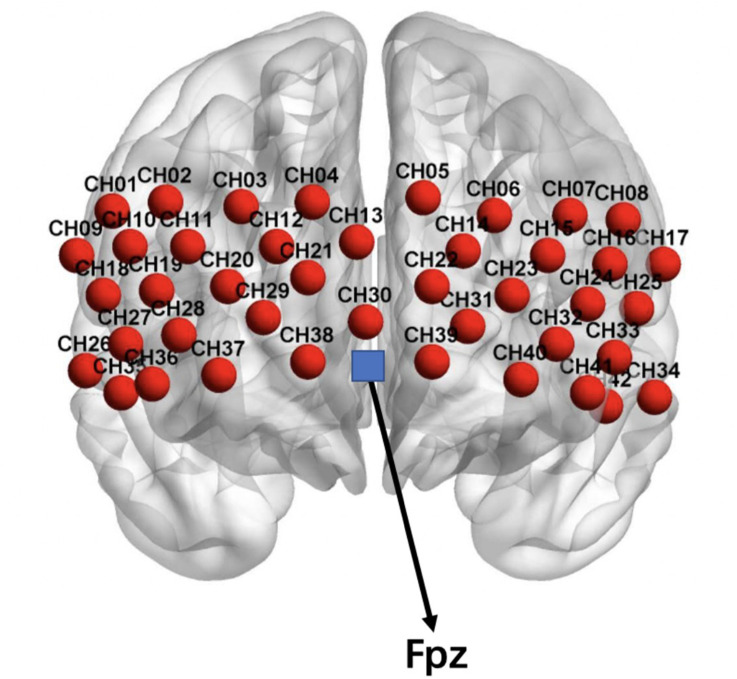
Layout of the fNIRS channels. The blue block represents the Fpz position.